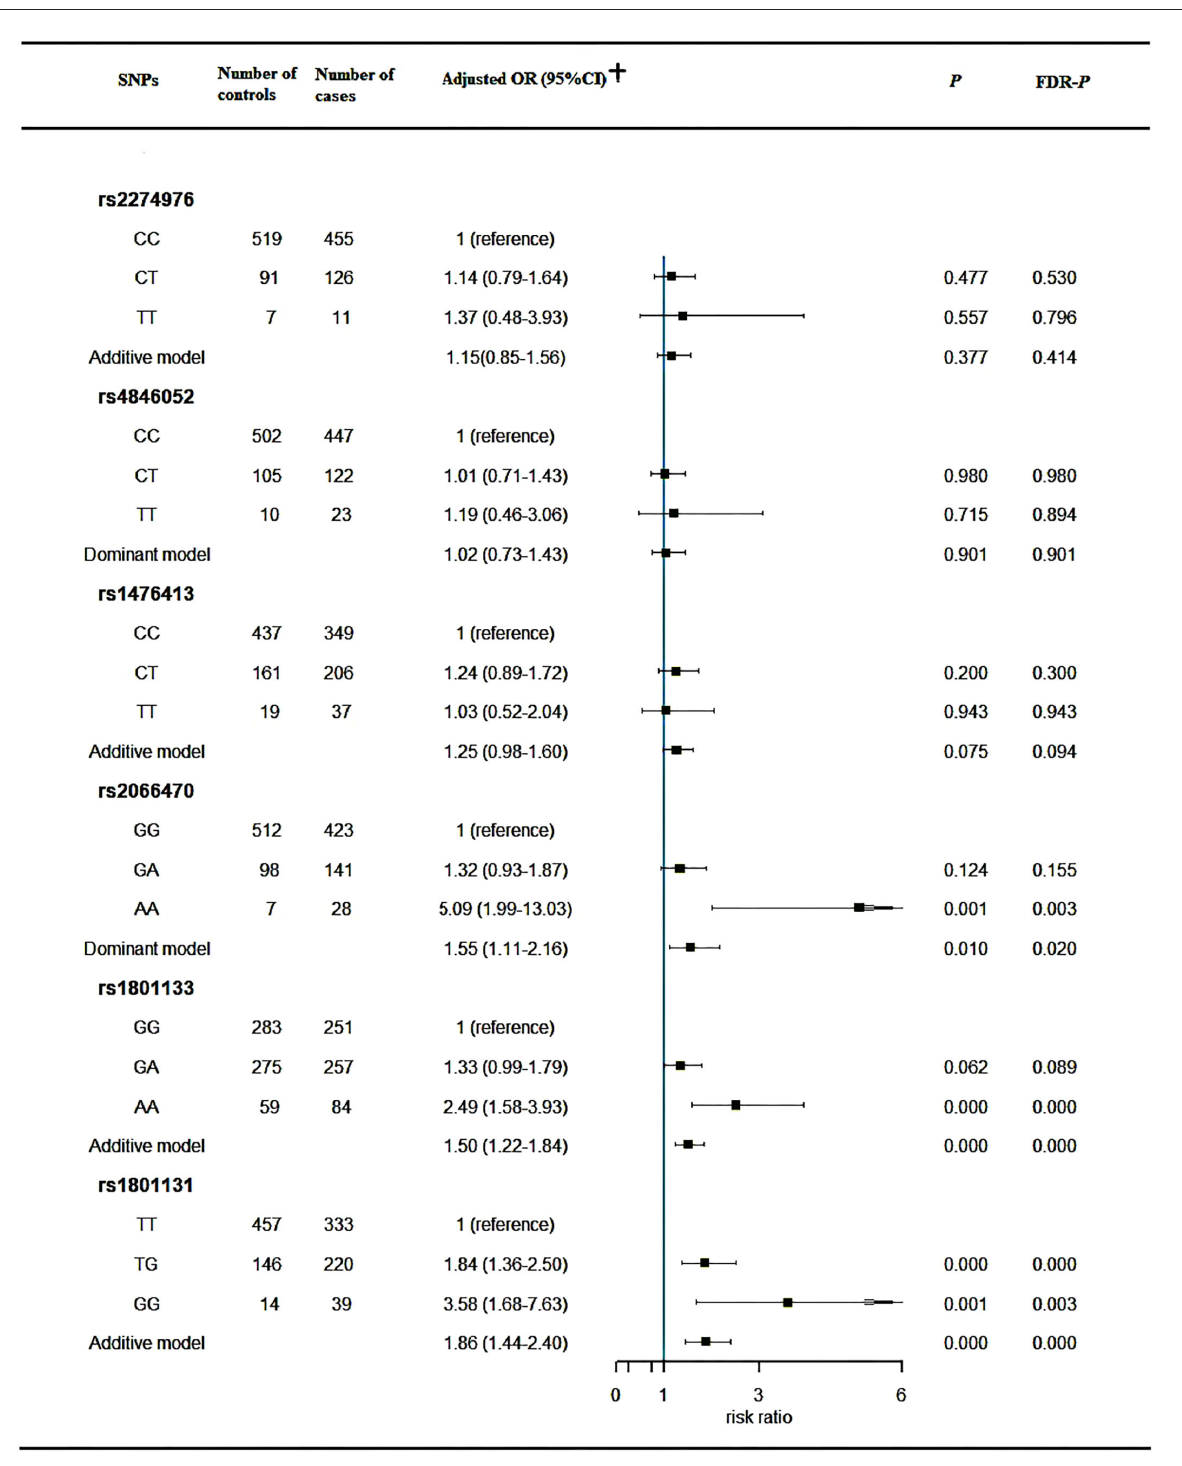
FIGURE1 Association between MTHFR genetic variants and risk of CHD. CHD, congenital heart disease; CI, confidence interval; OR, odds ratio; MTHFR, Methylenetetrahydrofolate reductase; FDR, false discovery rate. † Adjusted for gender, maternal education status, residence location, adverse pregnancy history (induced abortion or labor, fetal death or stillbirth, neonatal death, hypertension of pregnancy, gestational diabetes mellitus), family history (consanguineous marriages), maternal lifestyle before this pregnancy, harmful chemical exposure history in this